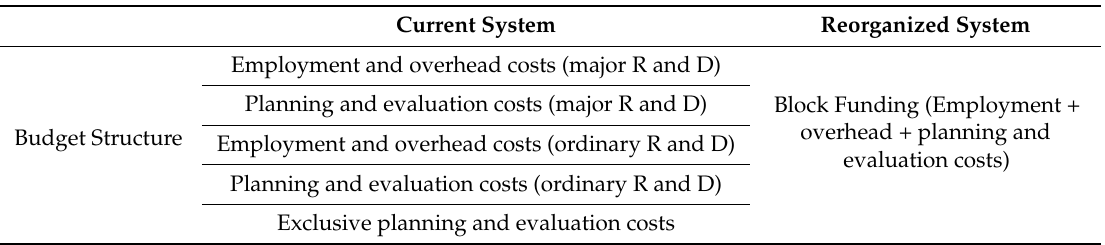
Table 10. Comparison between before and after the reorganization of the system of R and D planning and evaluation